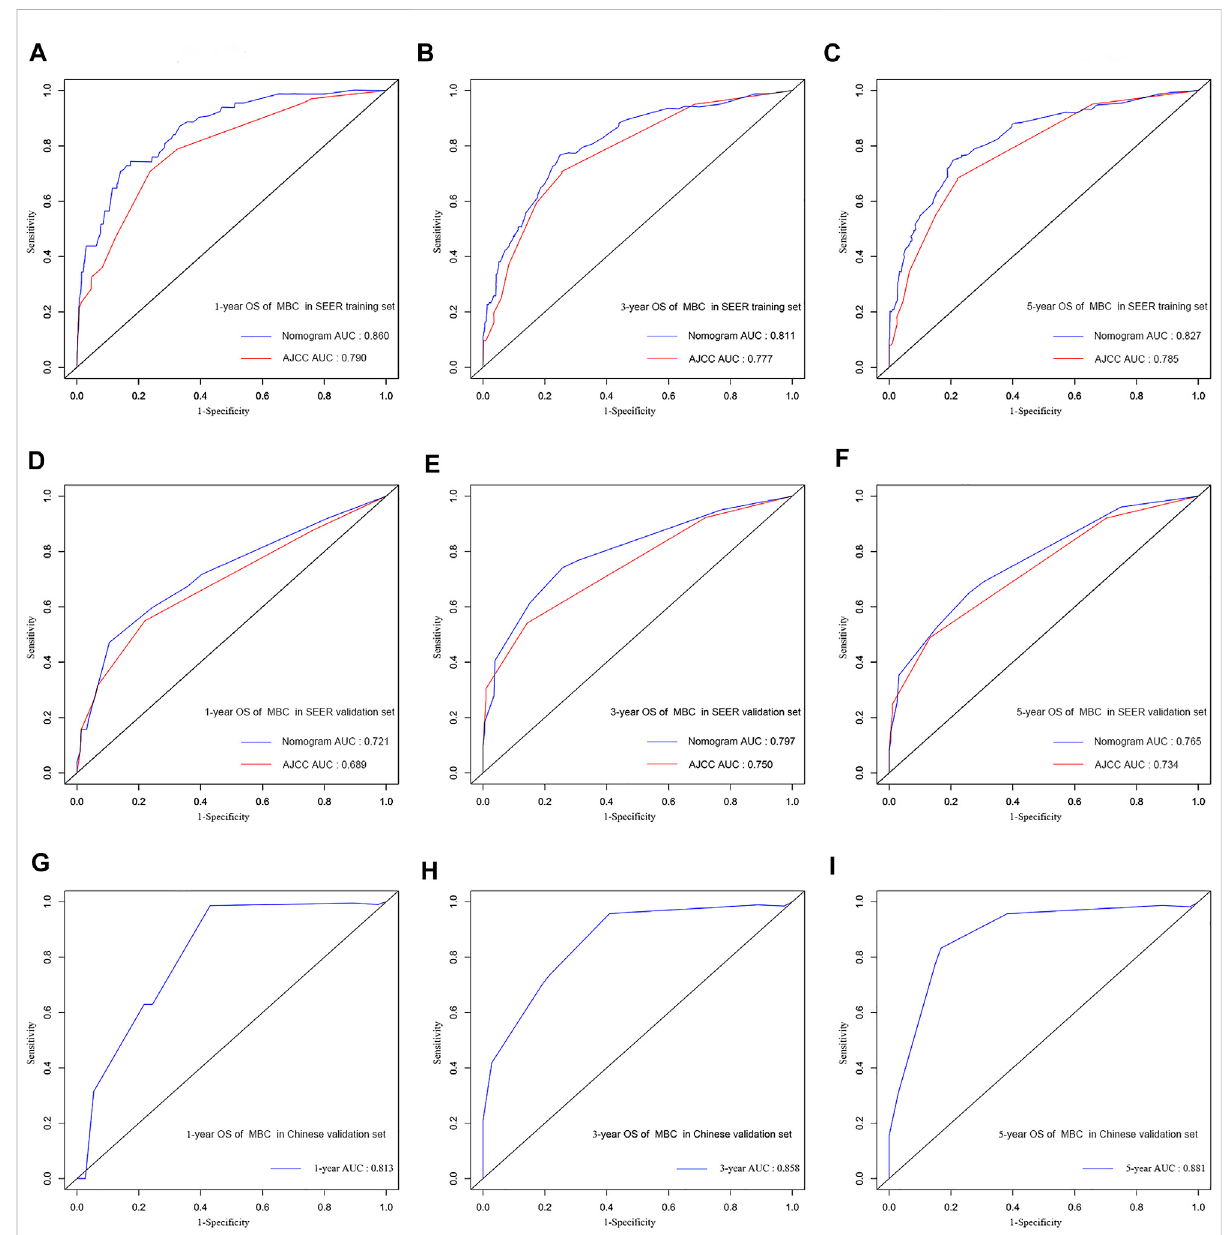
FIGURE 3 Comparison of the AUC of the nomograms and the eighth AJCC TNM staging system at 1, 3, and 5 years in the SEER training set (A,B,C) and in the SEER validation set (D,E,F) . ROC curves and AUC for nomograms at 1, 3, and 5 years in the multicenter validation set (G,H,I)